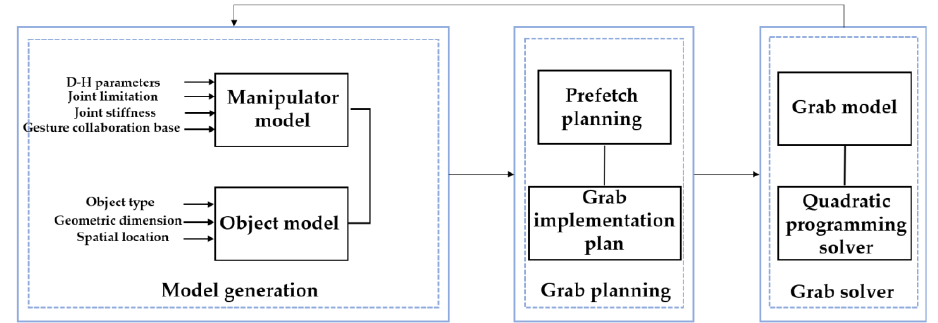
Figure 10. Flow chart of manipulator grasping simulation.